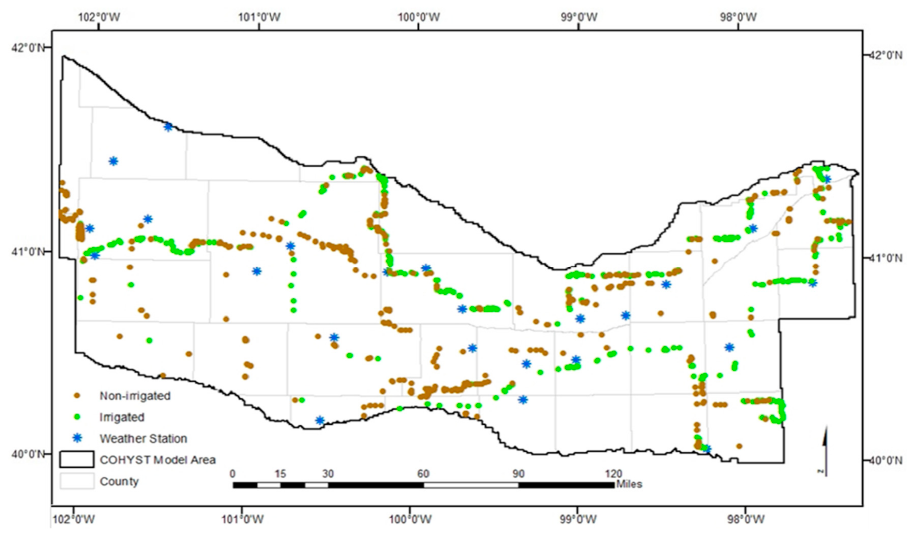
Figure 2. Sampled irrigated (355) and non-irrigated (464) groundtruth fields across the COHYST region during the 2014 growing season.